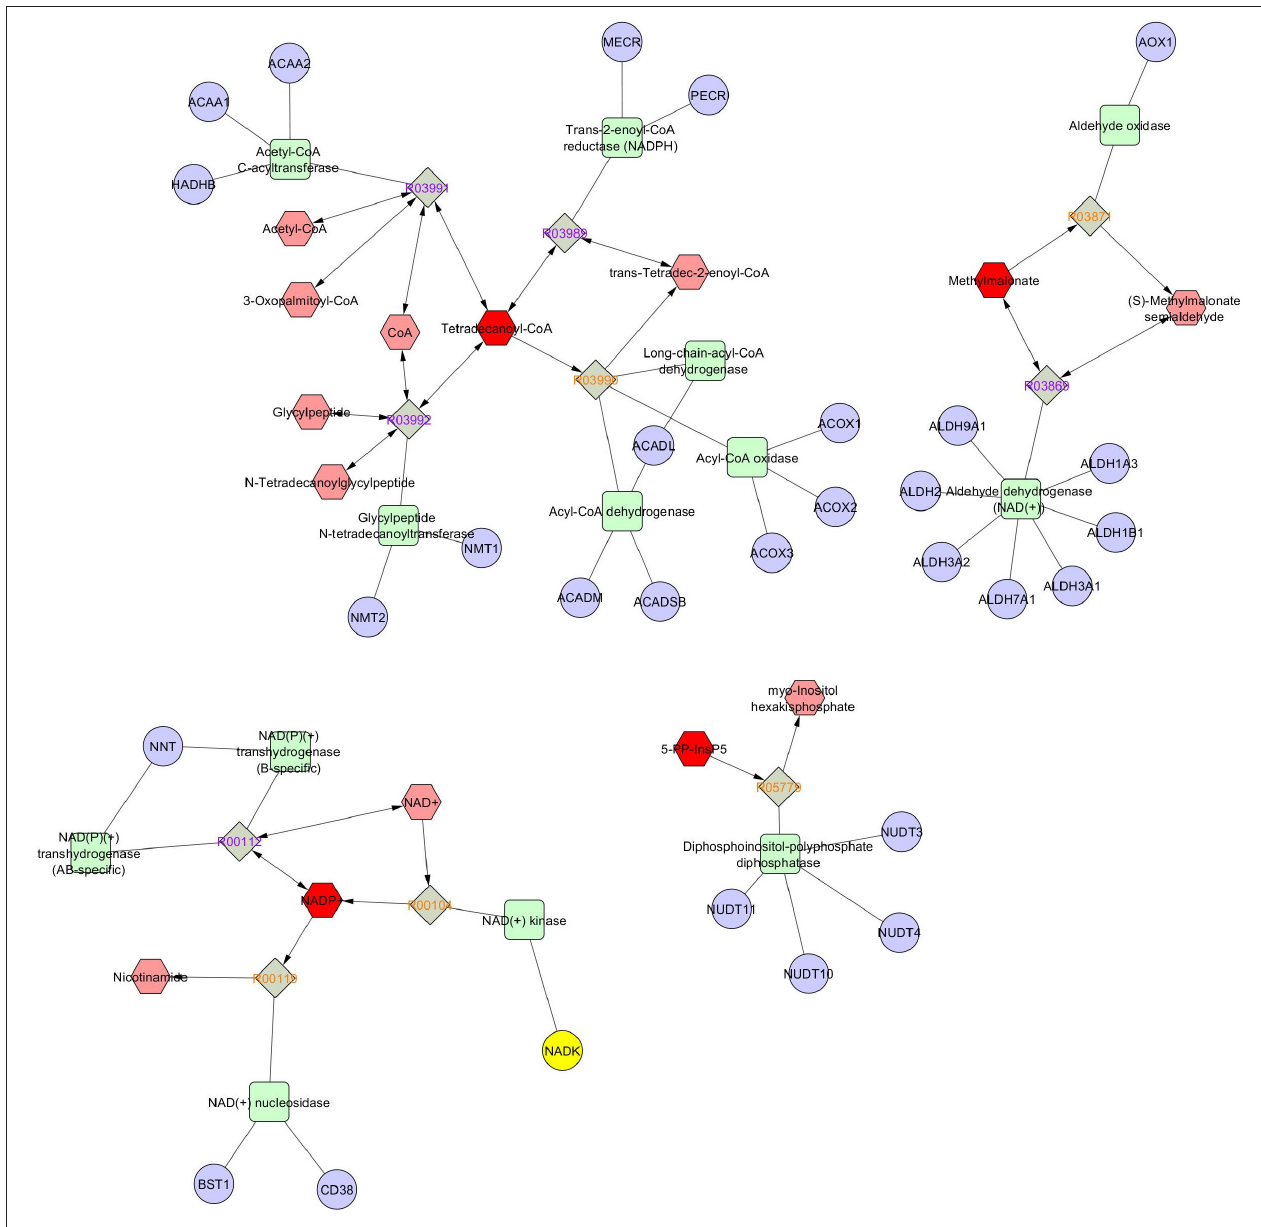
FIGURE 7 | Metscape of network based on compound-enzyme-gene reaction.